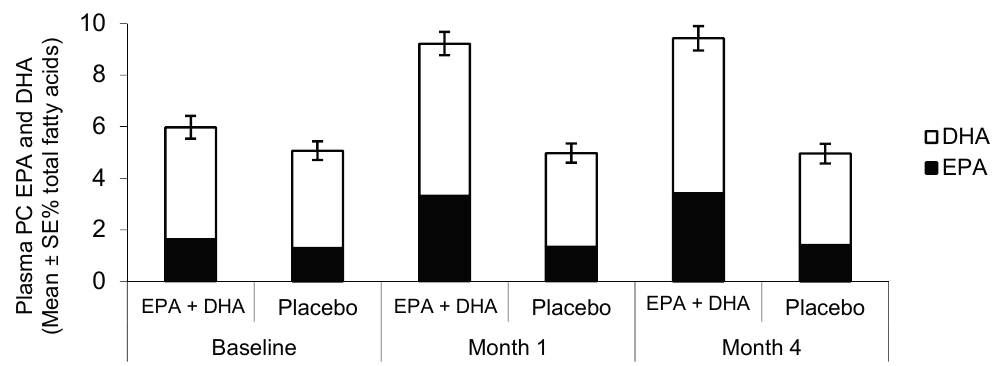
Figure 1. Plasma phosphatidylcholine EPA and DHA in the omega-3 and placebo groups at baseline, and after one and four months of treatment. Error bars are for total fatty acids (EPA + DHA). DHA, docosahexaenoic acid; EPA, eicosapentaenoic acid; PC, phosphatidylcholine.